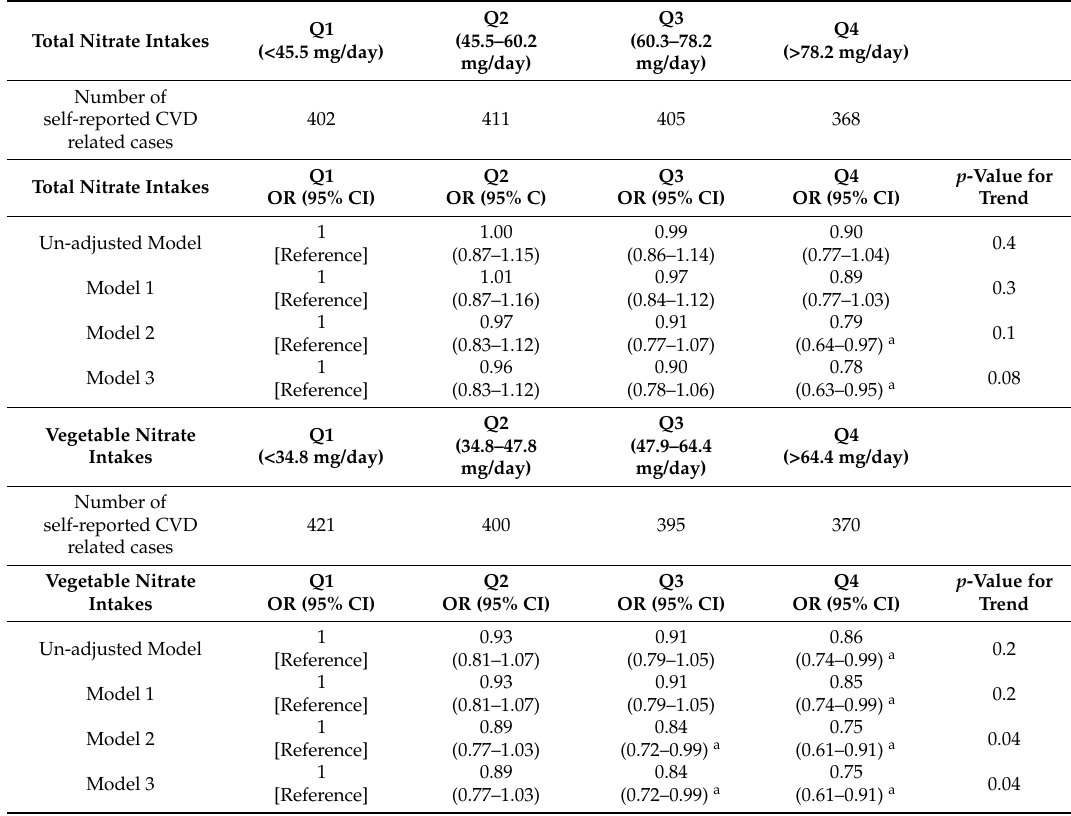
Table A2. Odds of self-reported CVD related complications (sensitivity analysis) by quartile of nitrate intakes in the 1946–1951 cohort of the ALSWH